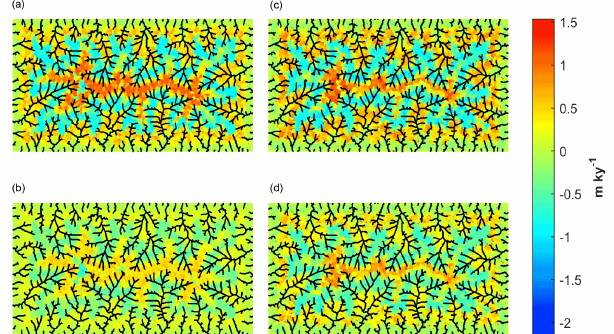
Figure 8. Spatial pattern of erosion rates during one model time step when simulating landscape evolution with the flux-limiting TVD-FVM vs. the first-order accurate implicit FDM. (a) Simula- tion at a resolution of 100m where the time step of the implicit method is not constrained. (b) Simulation at a resolution of 100m where the time step of the implicit method is constrained with the CFL criterion. (c) Simulation at a resolution of 500m where the time step of the implicit method is not constrained. (d) Simulation at a resolution of 500m where the time step of the implicit method is constrained with the CFL